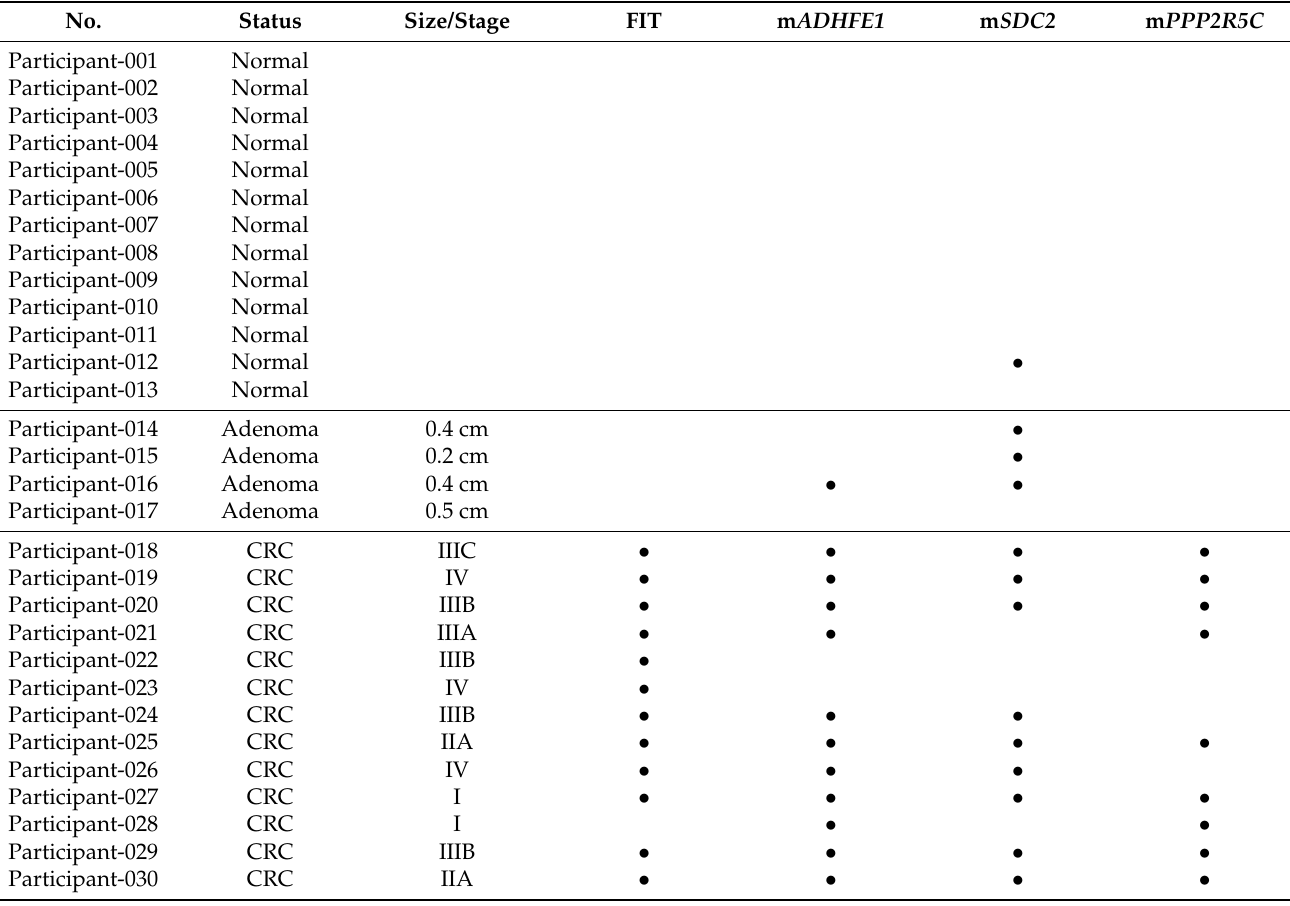
Table 3. Quantitative methylation specific PCR results and FIT detection status for individual participants.